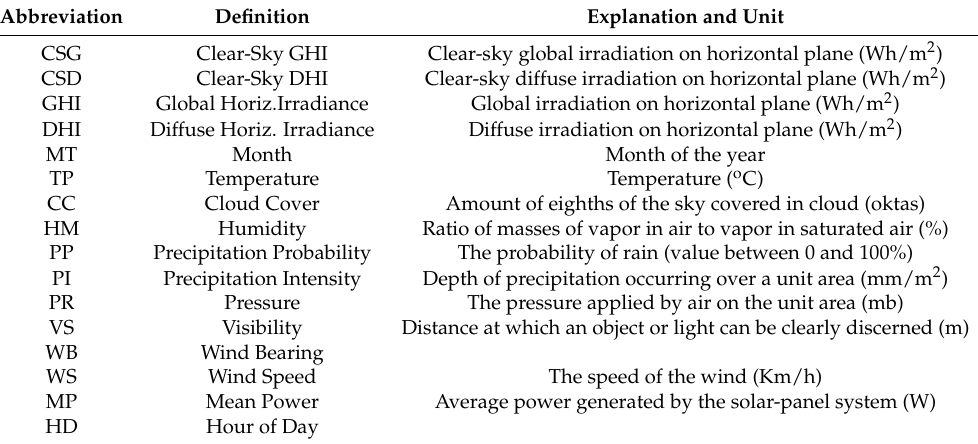
Table 3. Abbreviations, definitions, and explanations of the symbols used in Table